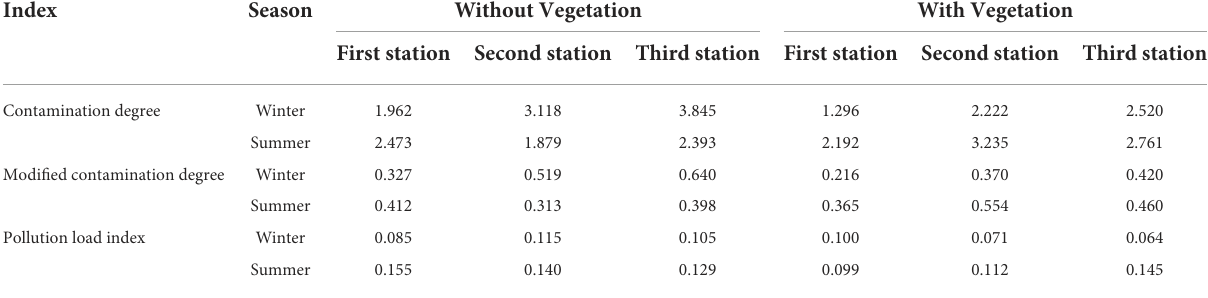
TABLE 5 Range of contamination degree (Cdeg), modified contamination degree (mCdeg), and pollution load indices in coastal Shadegan soils (winter and summer of 2019).